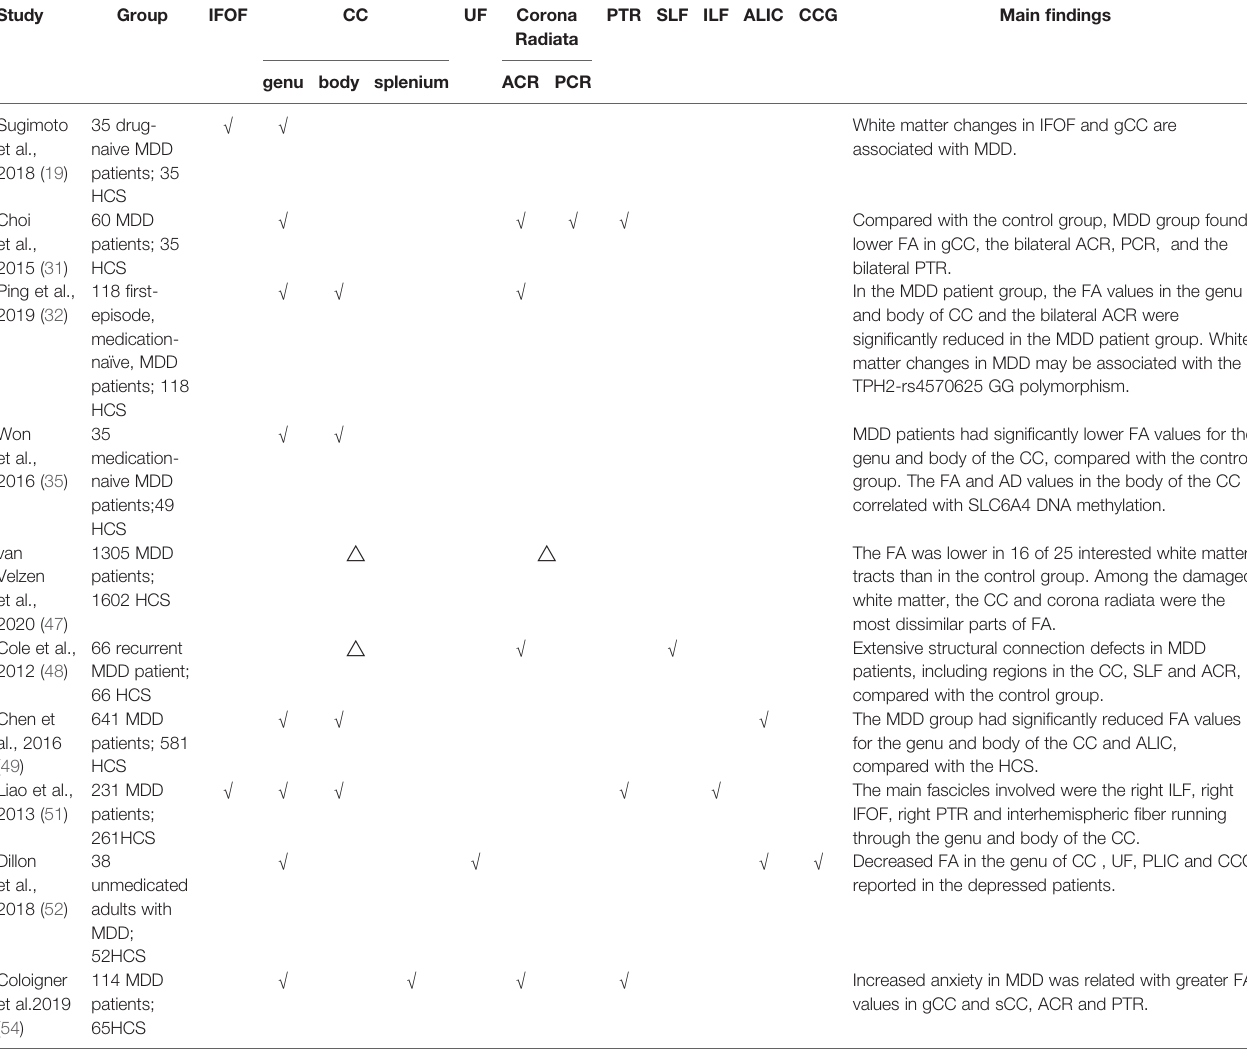
TABLE 1 | The summary of white matter alterations in MDD in this